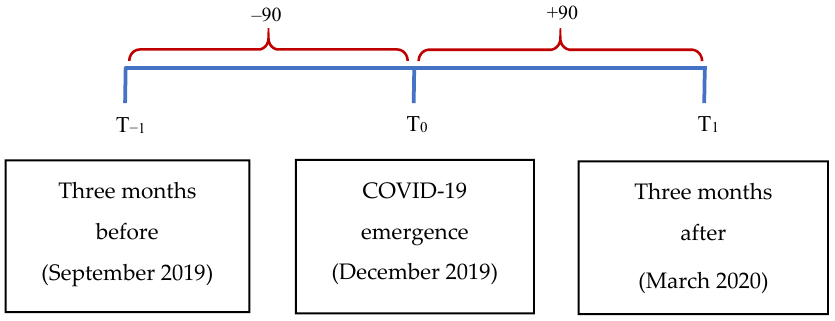
Figure 1. Observation Period.